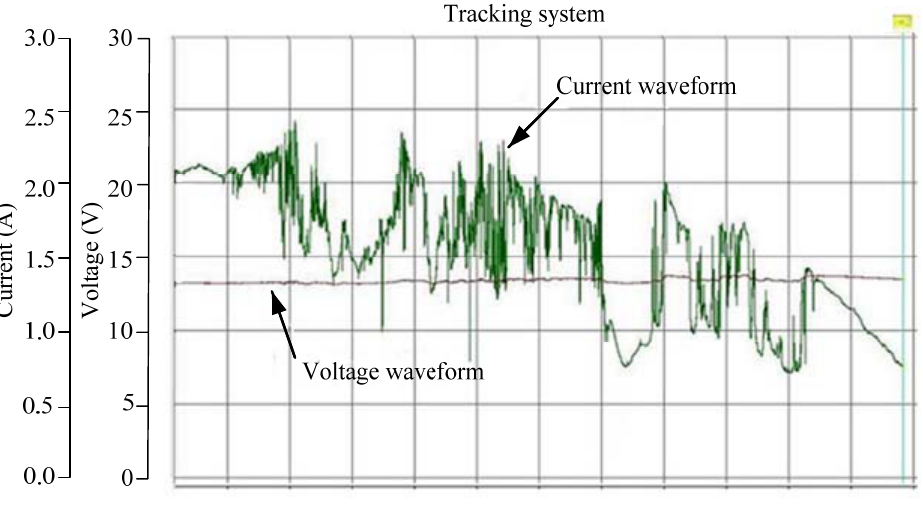
Figure 10. Measured time functions of output voltage and current for solar tracking system.